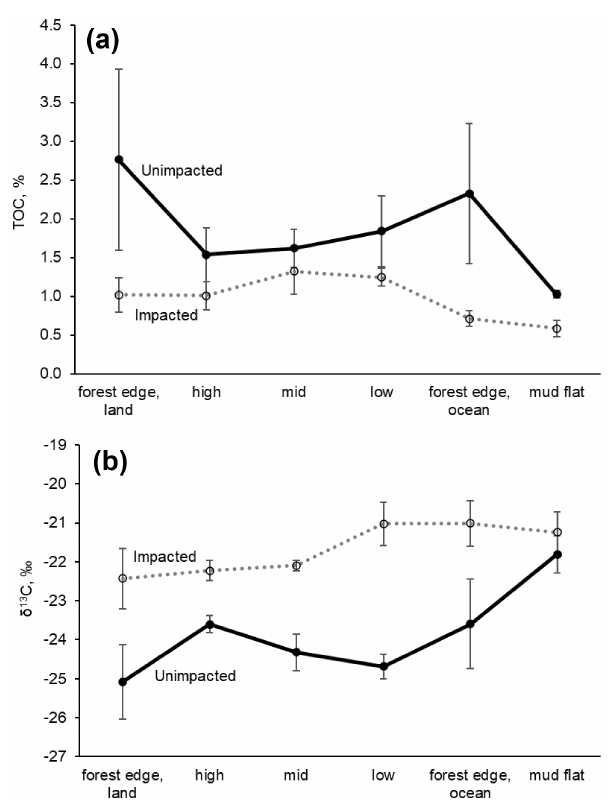
Figure 4. C elemental and isotopic compositions of surface ( < 0.5cm) sediment along the unimpacted reference transects vs. impacted transects ( n = 3 per data point). All samples were col- lected in 2018, 32 months after the dieback. Error values are SE. (a) Sediment TOC, %. (b) Sediment δ 13 C values,